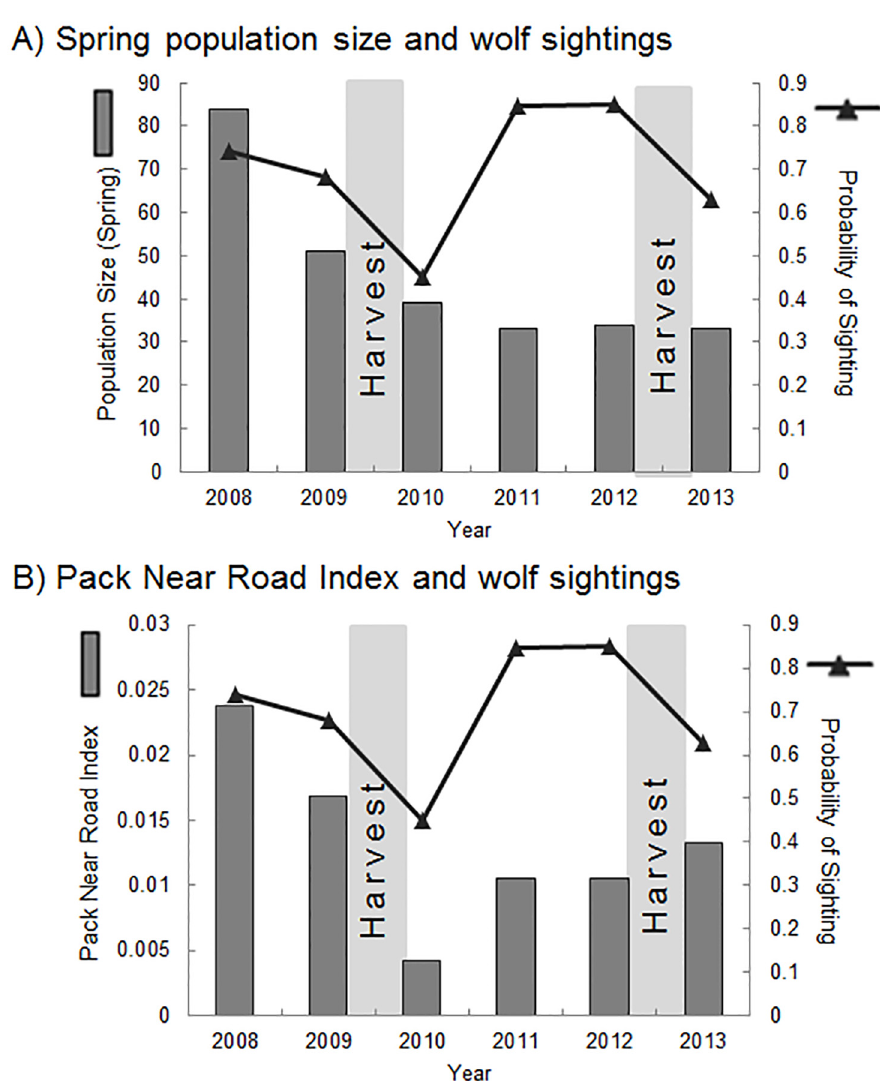
Fig 4. Probability of wolf sighting in Little America and Lamar Valley from 2008 – 2012 (black triangles) in relation to A) spring population size and B) Pack Near Road Index (number of wolves in road packs divided by den distances from the road) in Yellowstone National Park, Wyoming, USA. Shaded areas indicate years following harvest of wolves from packs. Two non-pack wolves were harvested prior to